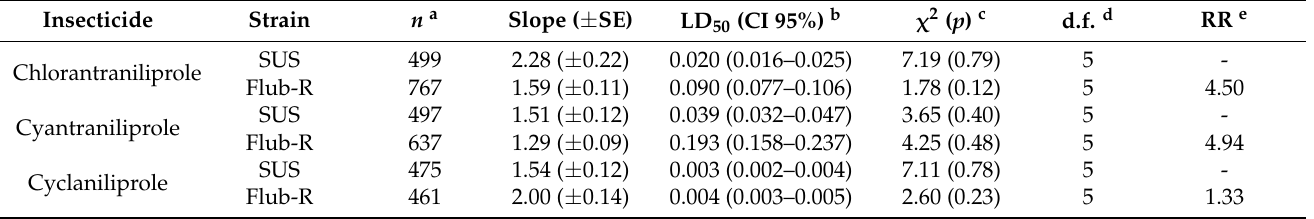
Table 3. Dose–mortality data for evaluating cross resistance between flubendiamide and anthranilic diamides in H. armigera .